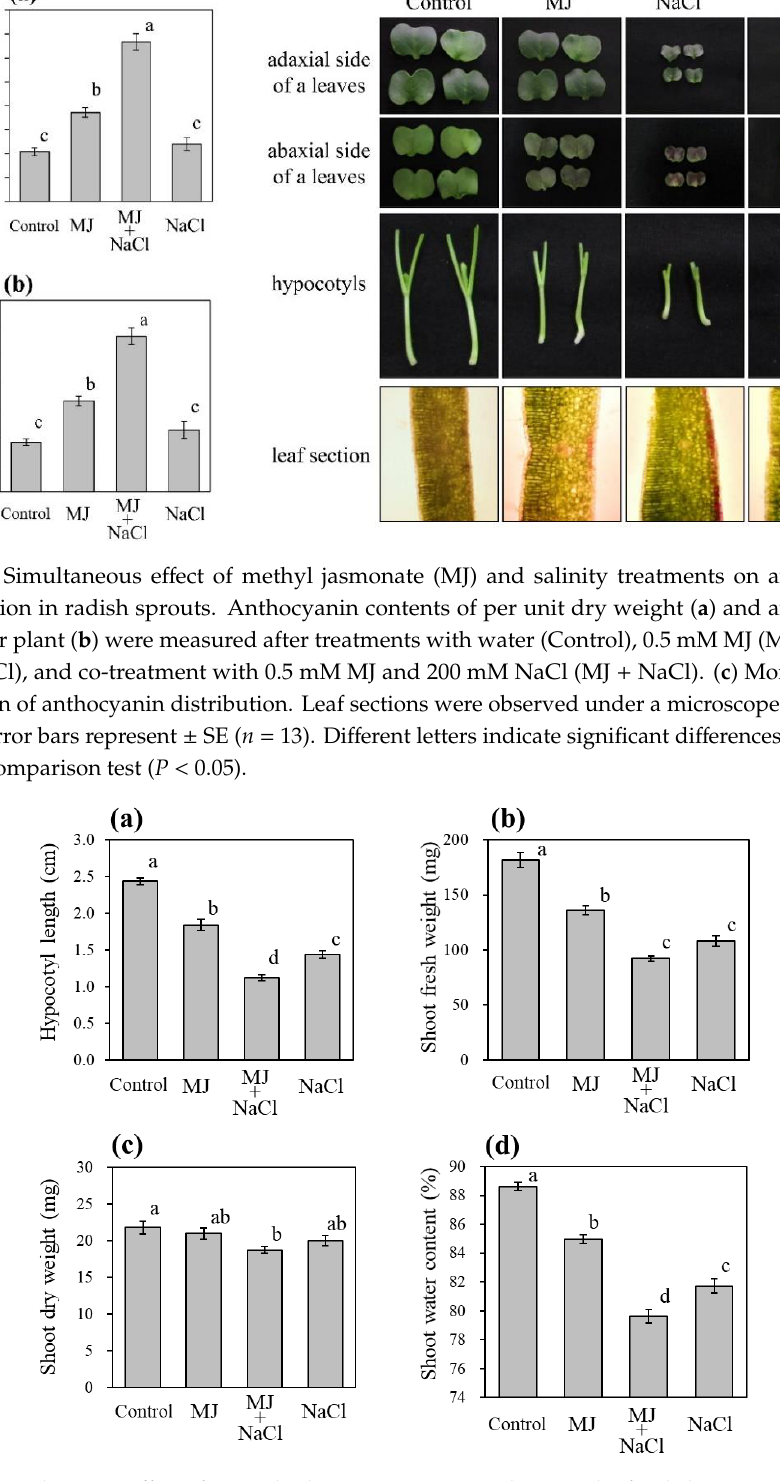
Figure 2. Simultaneous effect of MJ and salinity treatments on the growth of radish sprouts. Hypocotyl length ( a ), shoot fresh weight ( b ), shoot dry weight ( c ), and shoot water content ( d ) of sprouts after treatment with MJ (0.5 mM) and/or salinity (200 mM NaCl). Error bars represent ± SE (hypocotyl length and shoot fresh weight; n = 24; shoot dry weight and water content; n = 16). Different letters indicate significant differences by Tukey’s multiple comparison test ( P < 0.05).